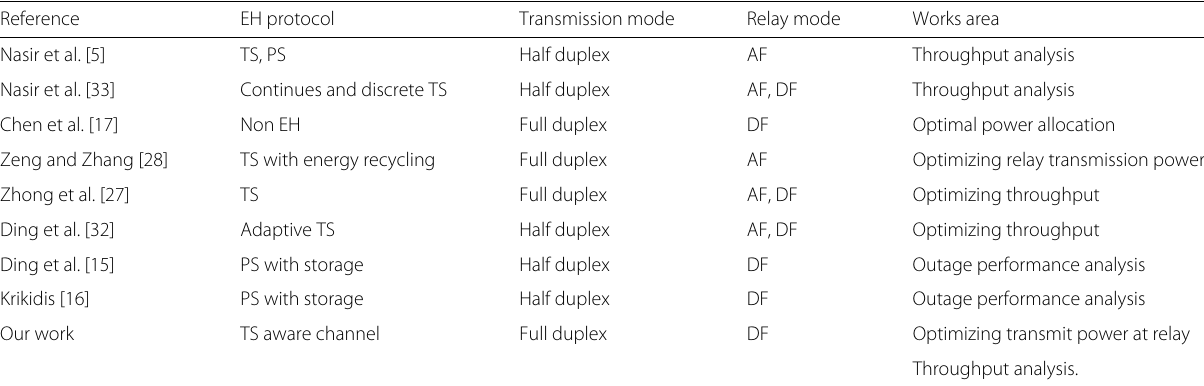
Table 2 The previous relevant works and their contributions Reference